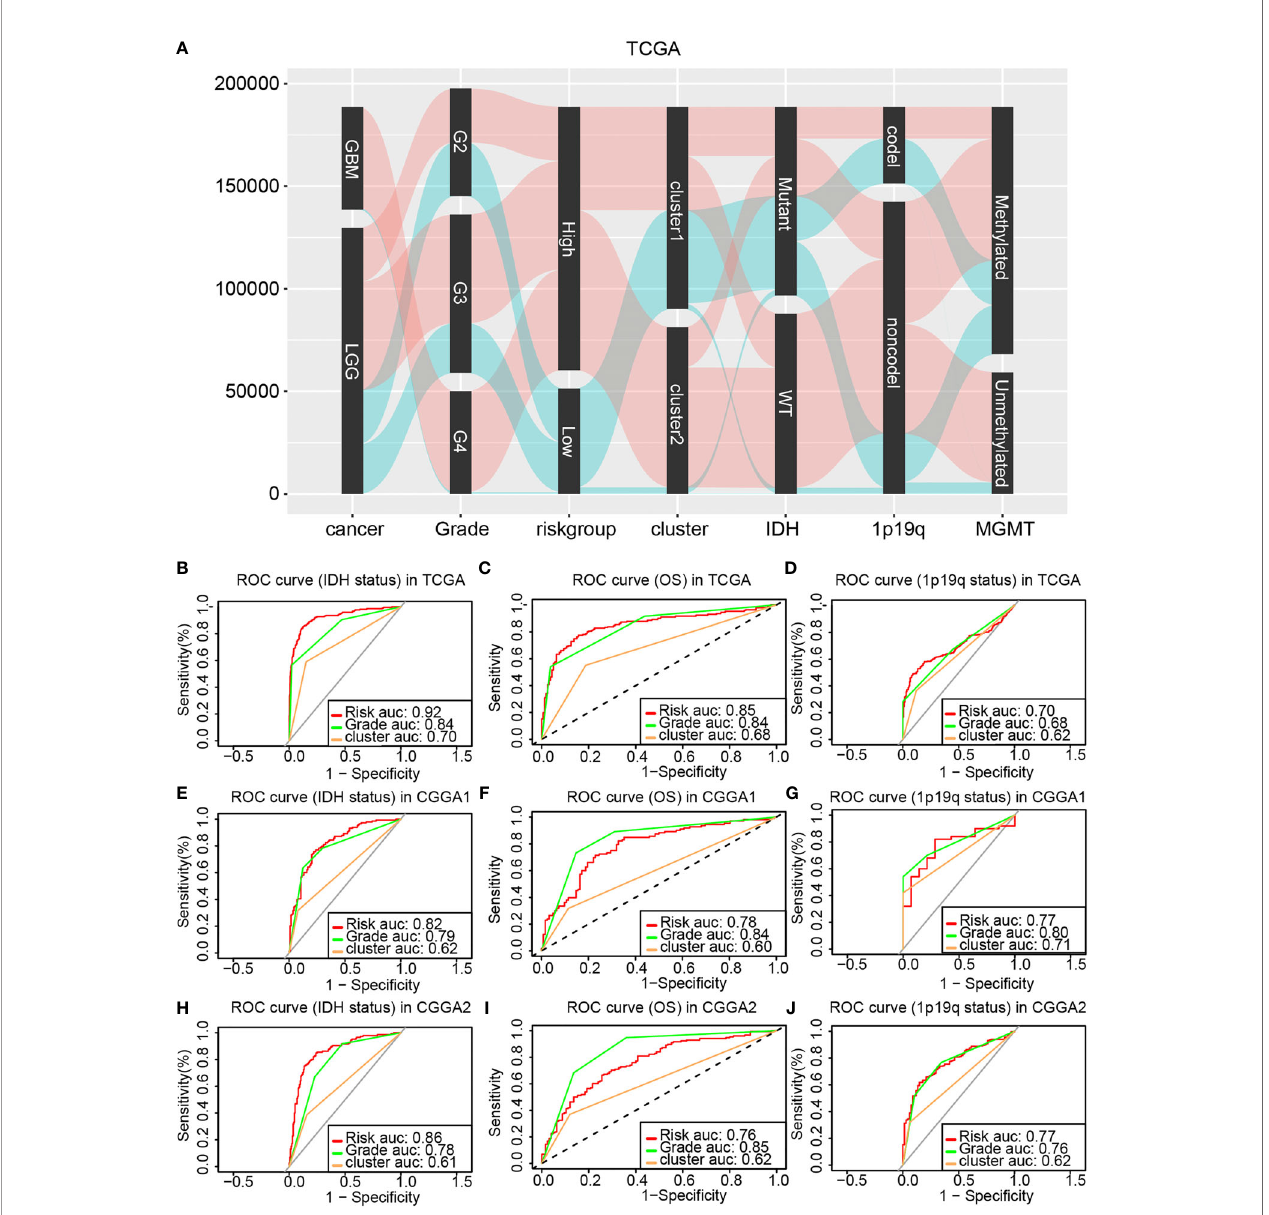
FIGURE 7 | Comparing the prognostic ability of the cluster model, the risk model, and glioma pathological grade. (A) The Sankey diagram revealed the potential connection between glioma pathological grade, risk, cluster, IDH status, 1p19q status, and MGMT status. ROC curve generated based on the risk model by taking the IDH status (B) , OS (C) , and 1p19q status (D) as outcome variable in the training cohort. The validation of ROC curve in the CGGA1 (E – G) and CGGA2 (H – J)